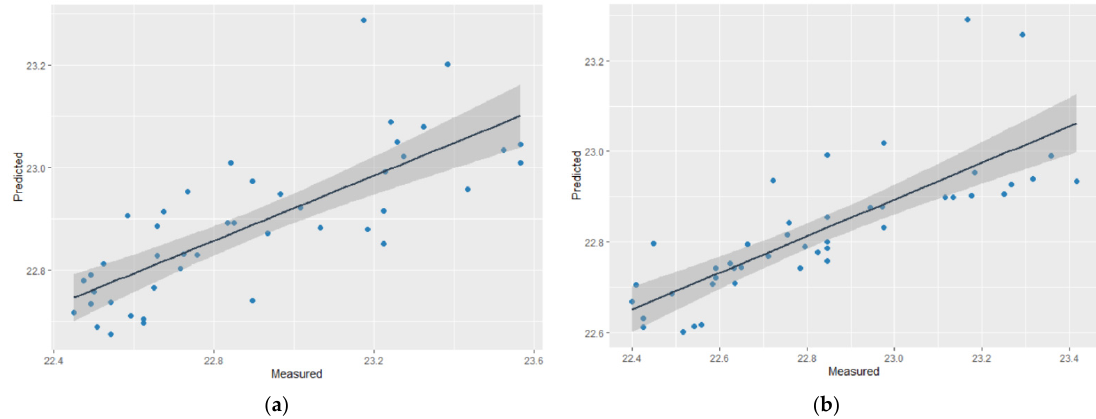
Figure 9. Sample of scatterplots of the observed and predicted greenhouse temperatures ( a ) June 14th from 12:00 a.m.—00:55 a.m. (summer); ( b ) September 14th from 12:00 a.m.—00:55 a.m. (autumn)